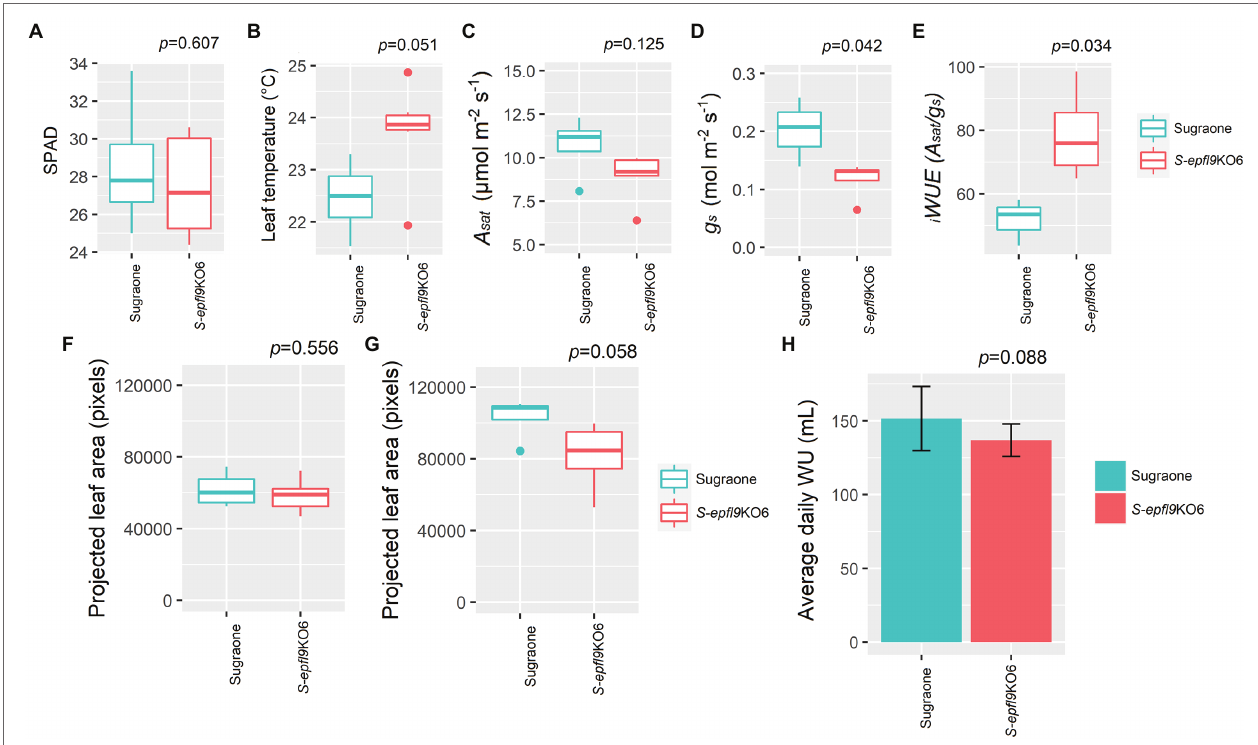
FIGURE 6 | Dynamics of gas exchange, projected leaf area and water-use under well-watered (WW) conditions (Experiment 3) for S- epfl9 KO6 ( n = 6) and ‘Sugraone’ WT ( n = 4). (A) SPAD values. (B) leaf temperature. (C) CO 2 assimilation rate at saturating light ( A sat ). (D) stomatal conductance ( g s ). (E) Intrinsic water-use efficiency ( i WUE ) calculated as i WUE = A sat / g s . (F,G) projected leaf area (PLA, pixels) collected at day 1 and at day 12, respectively, and (H) average daily water-use. For gas exchange measurements, data were collected on fully expanded leaves and were analysed with one-way ANOVA. Whiskers indicate the ranges of the minimum and maximum